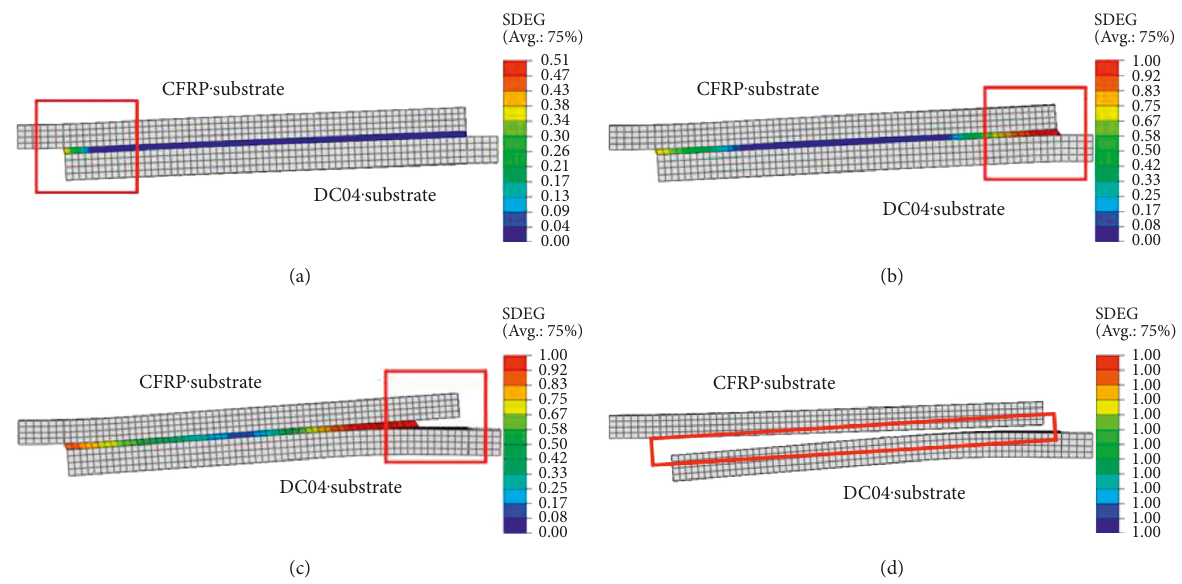
Figure 7: Failure process of the joints using 7779 adhesive with 30 mm overlap length: (a) beginning of degeneration; (b) degeneration proceeded; (c) cohesive failure appears and element deletion; (d) completely failure of adhesive